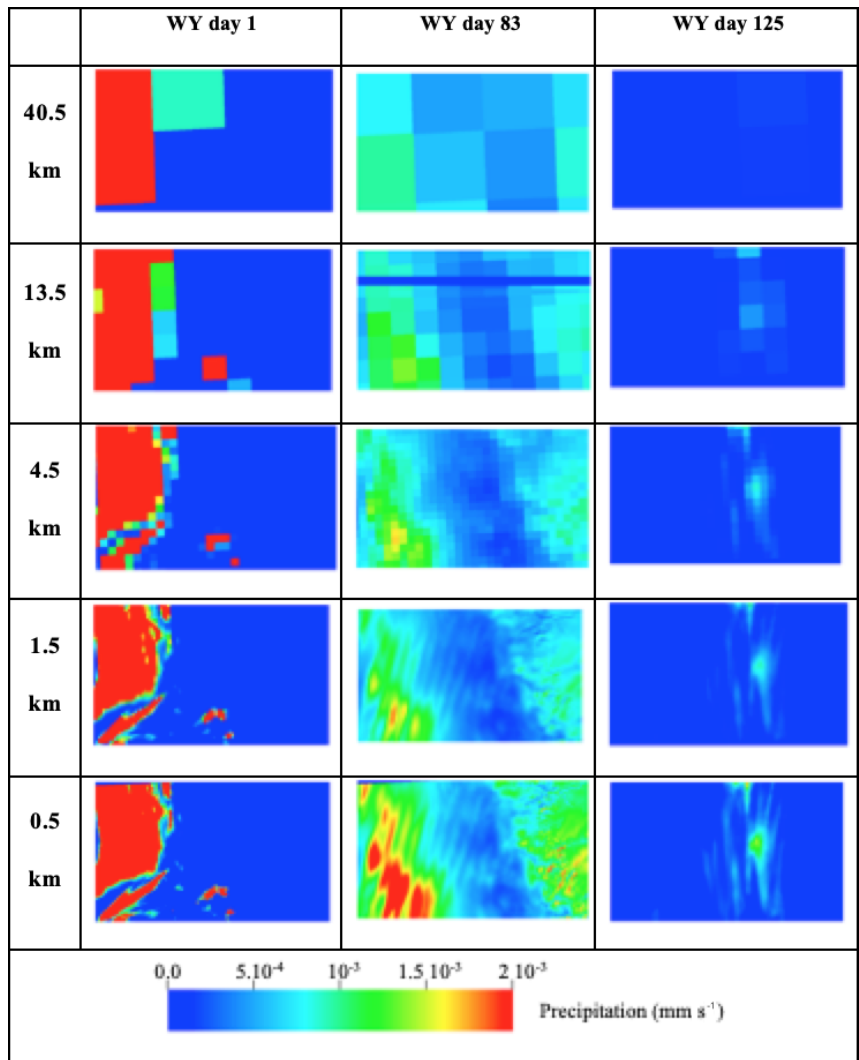
Figure A2. Spatial distributions of precipitation associated with the five spatial resolutions of meteorological forcing at three selected times corresponding to periods where the storm has high (day 1) and low (day 83) intensity and a time of very located and low intensity (day